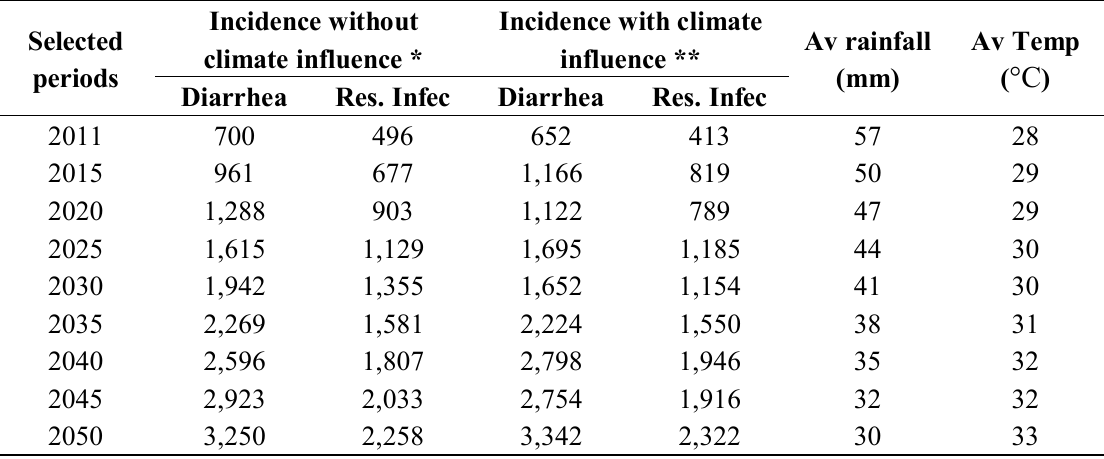
Table 6. Predicted incidence of major diseases with and without climatic influence for selected